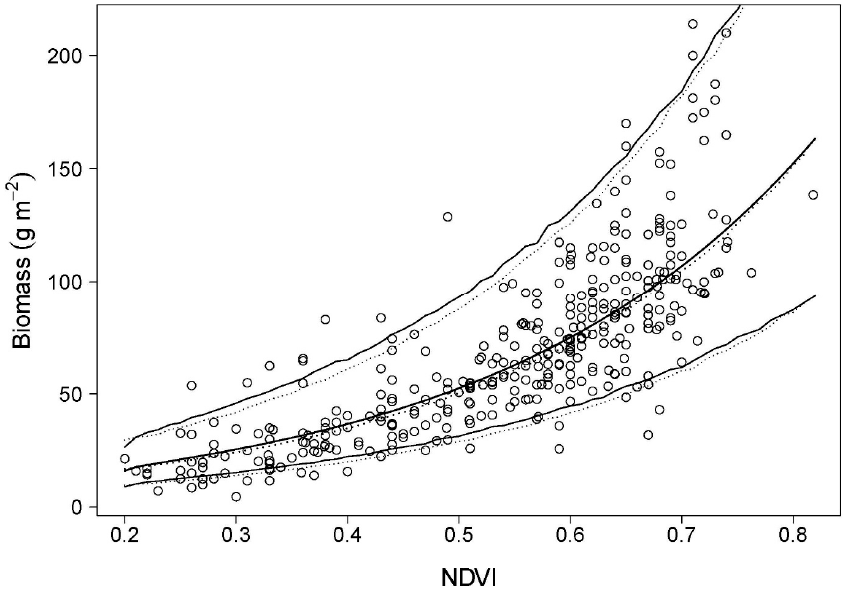
Figure 3. Relationship between graminoid biomass (g m − 2 ) and spectrometer-derived NDVI using WorldView-2 band definitions at the Colville River Delta, Alaska, 2012–2015. Open circles represent observed values. The bold solid line represents model-averaged predictions of biomass derived from a multi-model assessment with NDVI, temperature, precipitation, and date as predictor variables. The light solid lines depict the upper and lower 95% prediction intervals of the top-ranked model in Table 1, a close approximation of model-averaged predictions. The bold dashed line depicts predicted biomass as a function of spectrometer-derived WorldView-2 NDVI in the absence of environmental variables (i.e., the seventh-ranked model in Table 1), fitting the model log 10 (biomass) = 0.812 + 1.762(SR WV2 ); the light dashed lines delimit the upper and lower 95% prediction intervals of this relationship.